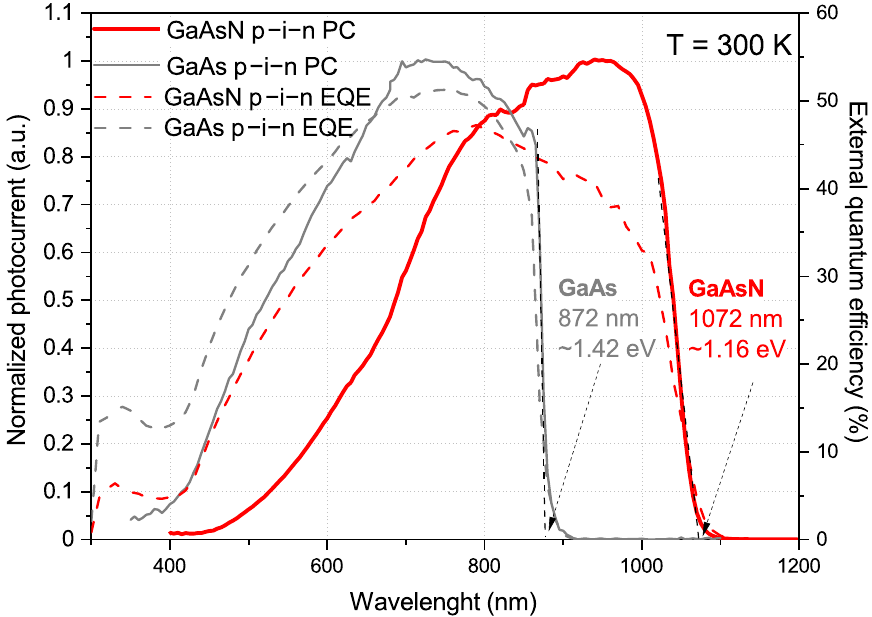
Figure 3. Photocurrent spectra (straight lines) and external quantum efficiencies (dashed lines) of GaAsN (red lines) and GaAs (gray lines) reference structure p-i-n solar cells. Fabricated GaAsN test solar cells were characterized by J-V measurements under an AM1.5 solar spectrum simulator in order to obtain basic photovoltaic parameters. The typical J–V curve of the test device is shown in Figure 4. We obtained an open-circuit voltage of 0.461 V and short-circuit current density of 21.53 mA/cm 2 , while fill factor and efficiency were equal to 71.97% and 7.11%, respectively. Bouzazi, who investigated a GaAsN-based solar cell, obtained higher V oc = 0.66 V in comparison with our structure, but lower a short-circuit current J sc of 16.52 mA/cm 2 and fill factor of 65%. Finally, both structures, ours and fabricated by Bouzazi have similar efficiencies of 7.11% and 7.10%, respectively